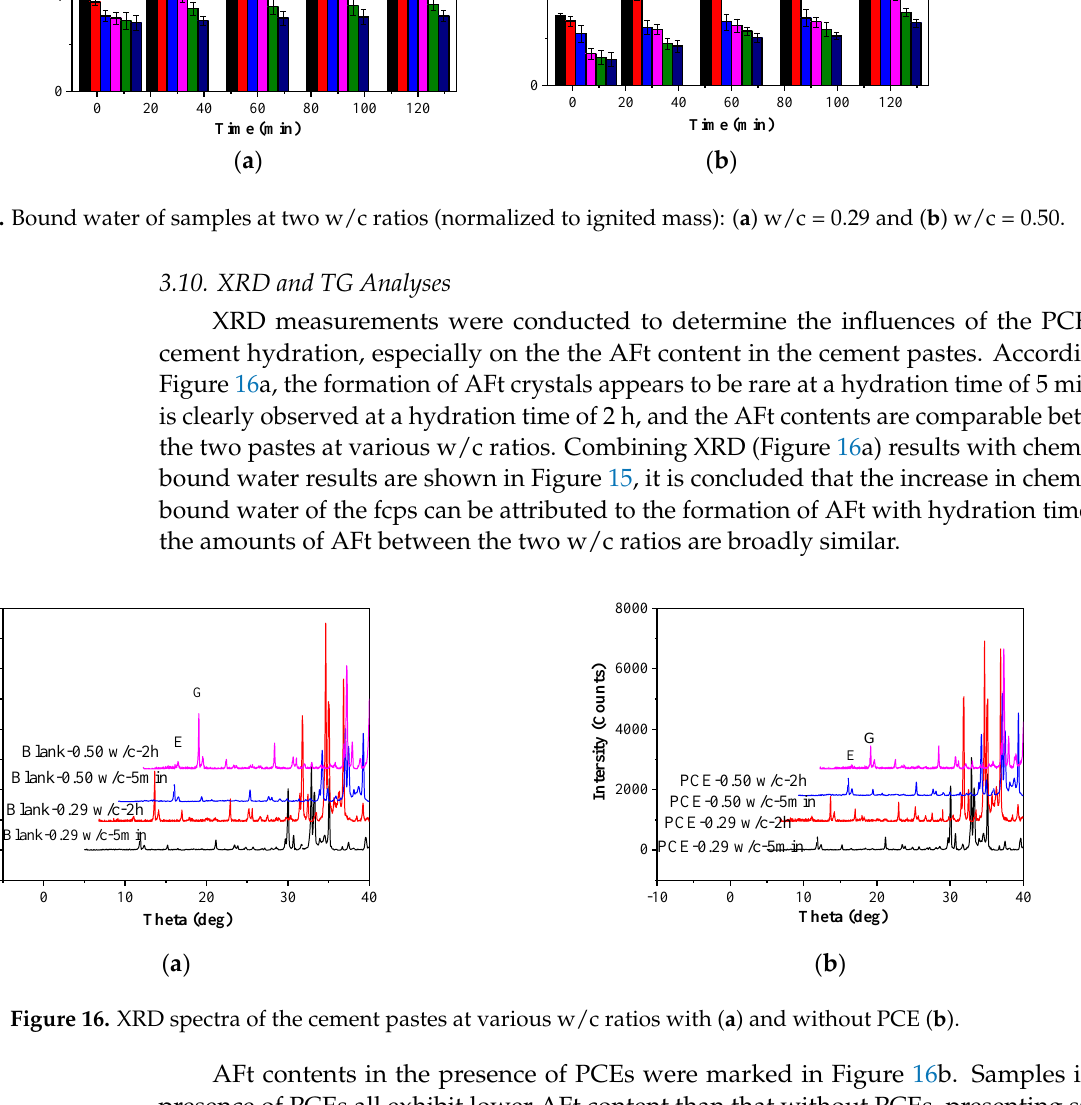
Figure 15. Bound water of samples at two w/c ratios (normalized to ignited mass): ( a ) w/c = 0.29 and ( b ) w/c = 0.50.